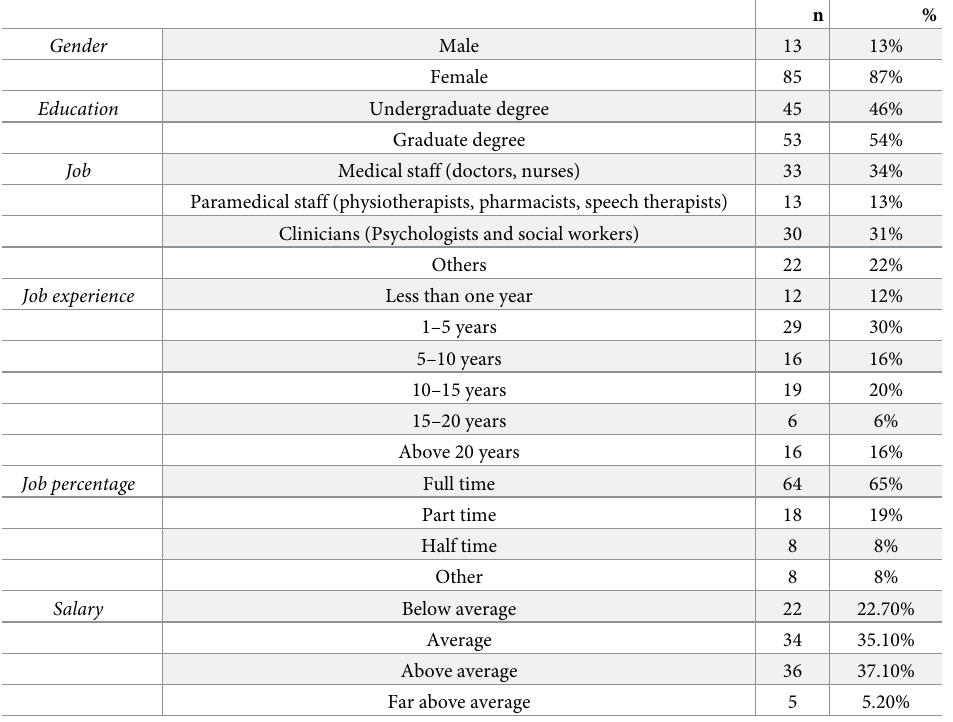
Table 1. Demographic characteristics of the participants (N =